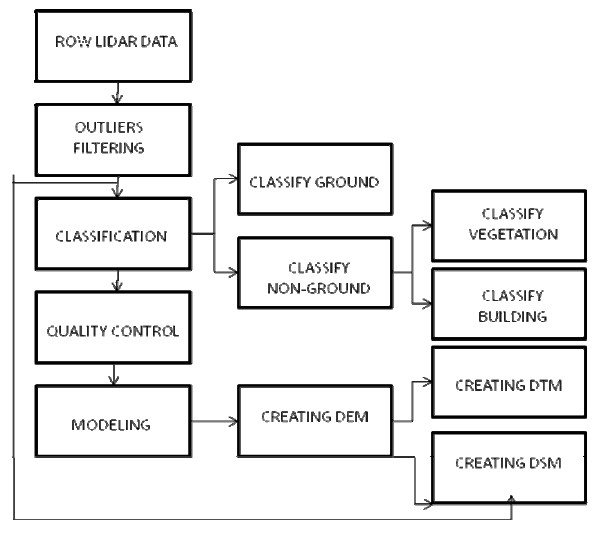
Figure 1: workflow for DSM and DTM extraction Fig. 1. Workflow for DSM and DTM